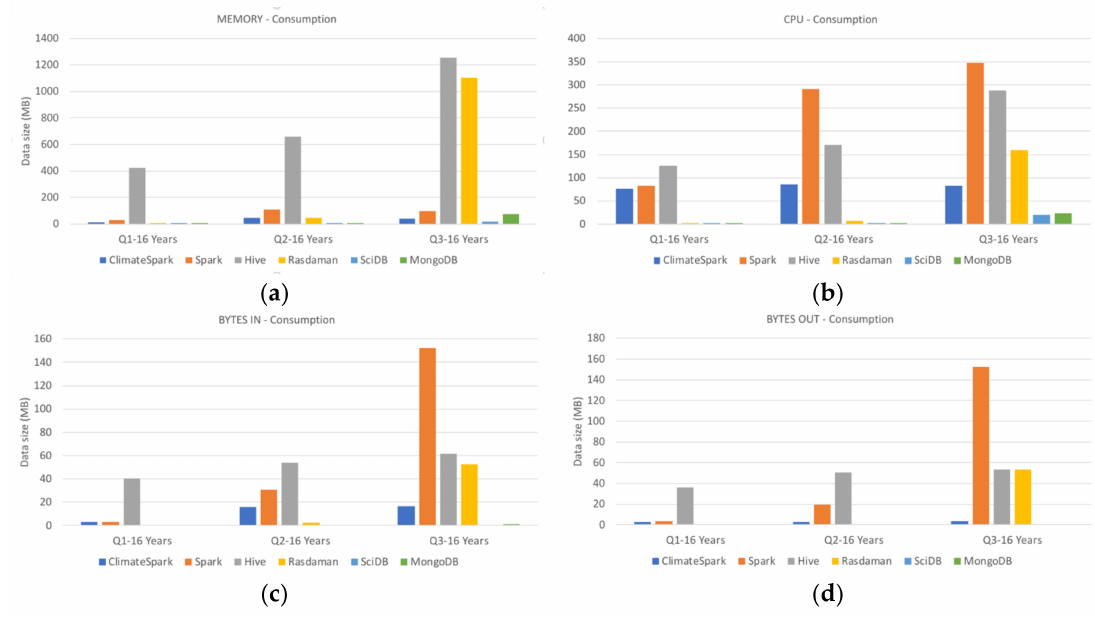
Figure 10. Resource monitoring result for the spatiotemporal query experiment on the 3D variable for 16 years: ( a ) average memory consumption; ( b ) average CPU consumption; ( c ) average byte-in volume; and ( d ) average bytes-out